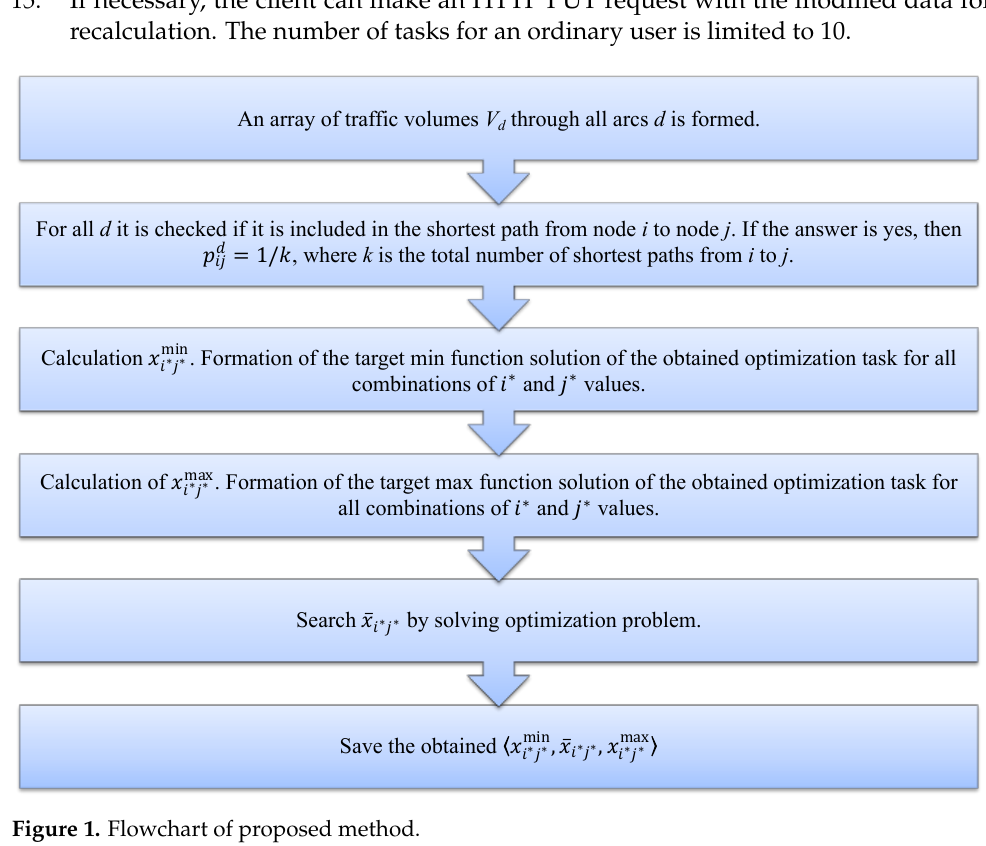
Figure 1. Flowchart of proposed